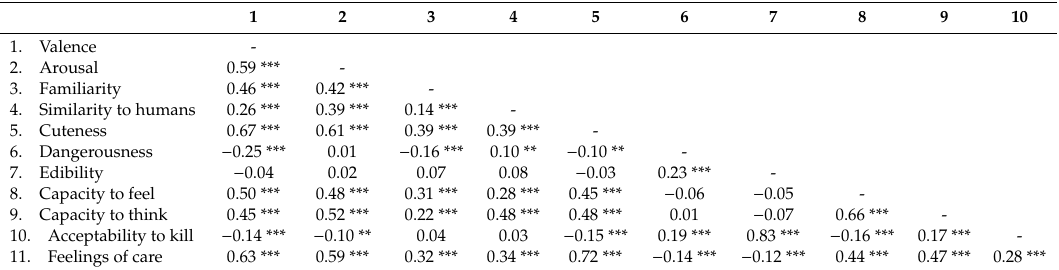
Table 2. Correlations between the 11 evaluative dimensions (Pearson’s r